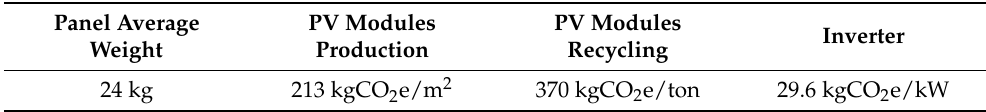
Table 2. Emissions factors. Adapted from